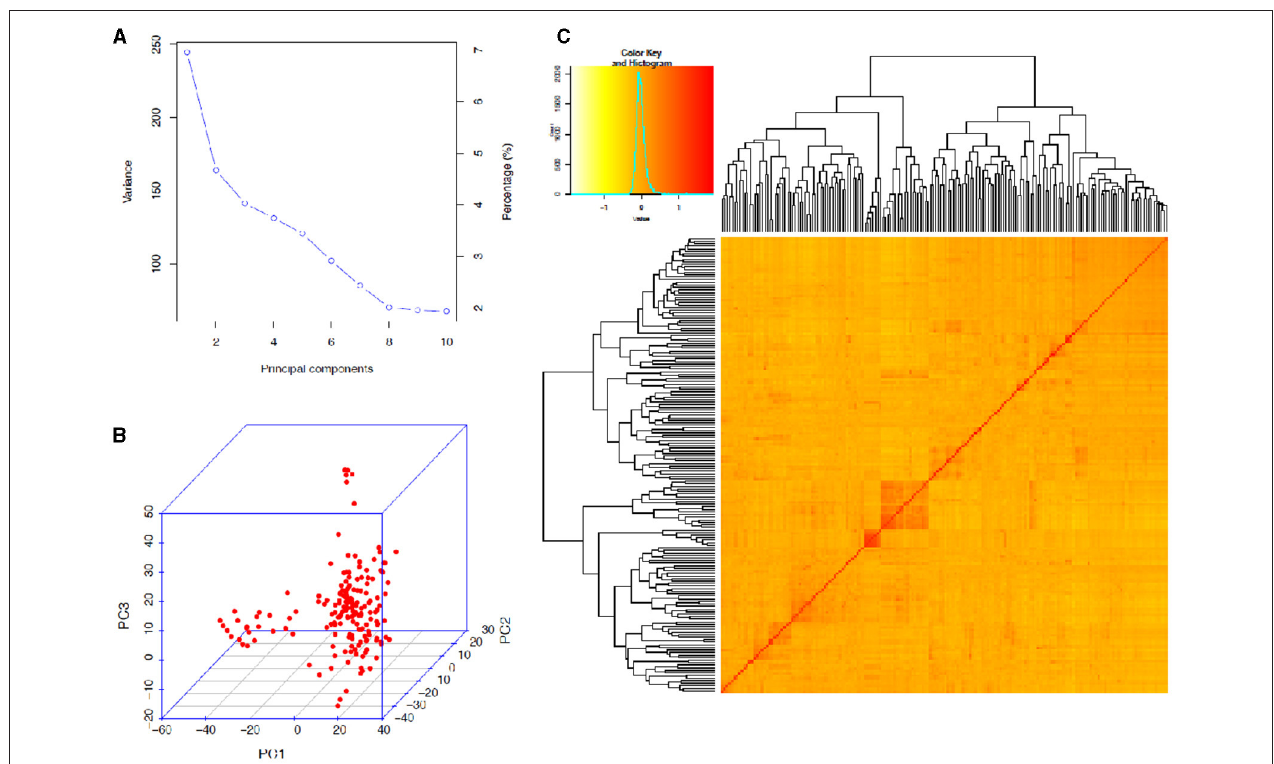
FIGURE 4 | Principal component and familiar relatedness analyses of 178 bread wheat genotypes based on 7,776 genome-wide scanned, high-quality SNPs. (A) A screen plot displaying the first 10 principal components with their corresponding fraction of variation explained, (B) 3D plots of the first three principal components to depict the samples’ relationship in space, and (C) Heat map showing the kinship analysis. The kinship values showed a normal distribution (turquoise curve), and orange and red colors represent weak and high kinship relations in the panel, respectively. The resulted clustering tree is indicated outside of the